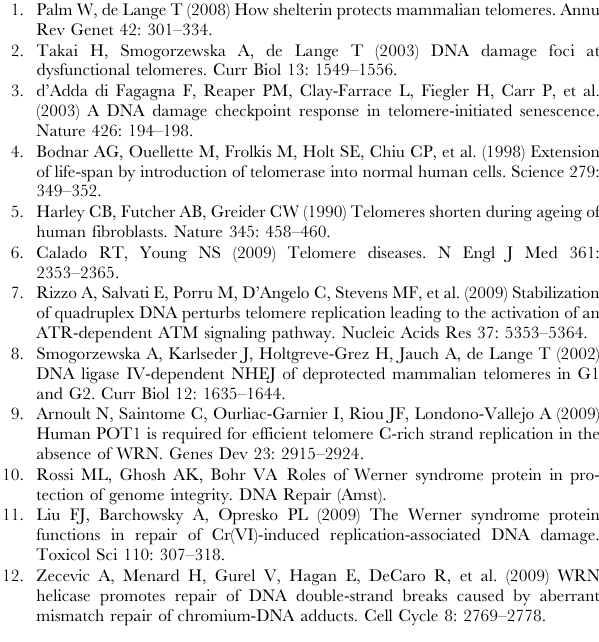
Found at: doi:10.1371/journal.pone.0011152.s001 (0.70 MB EPS) Figure S1 WRN does not prevent TIF formation. Confocal images of shCtrl and shWRN U2OS cells exposed to 4 m M Cr(VI) for 48 h (A) and then cultured in Cr(VI)-free medium for 12 h (B). (C) Average c H2AX foci and TIF number per cell and the percent of TIF positive cells from (A). The data represent mean 6 SE from two independent experiments, based on at least 50 randomly chosen cells for each Cr(VI) treatment. Found at: doi:10.1371/journal.pone.0011152.s002 (1.96 MB EPS) Figure S2 WRN deficiency does not affect Cr(VI)-induced doublets and telomeric DNA-containing double minute chromo- somes (TDMs). shCtrl and shWRN cells were exposed to 0 and 3 m M Cr(VI) for 48 h and cultured in Cr(VI)-free medium for 10 h. (A) Average doublets per chromosome. (B) Average TDMs per chromosome. Around 40 metaphases from two independent experiments were analyzed to quantitate Cr(VI)-induced telomere instability. Found at: doi:10.1371/journal.pone.0011152.s003 (0.70 MB